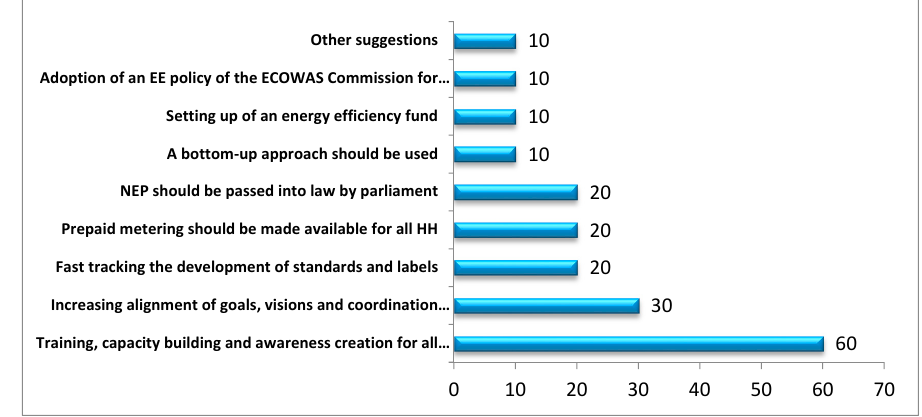
Figure 14. Policy recommendations (in percentage of experts interviewed in favor of particular policy approaches and measures).